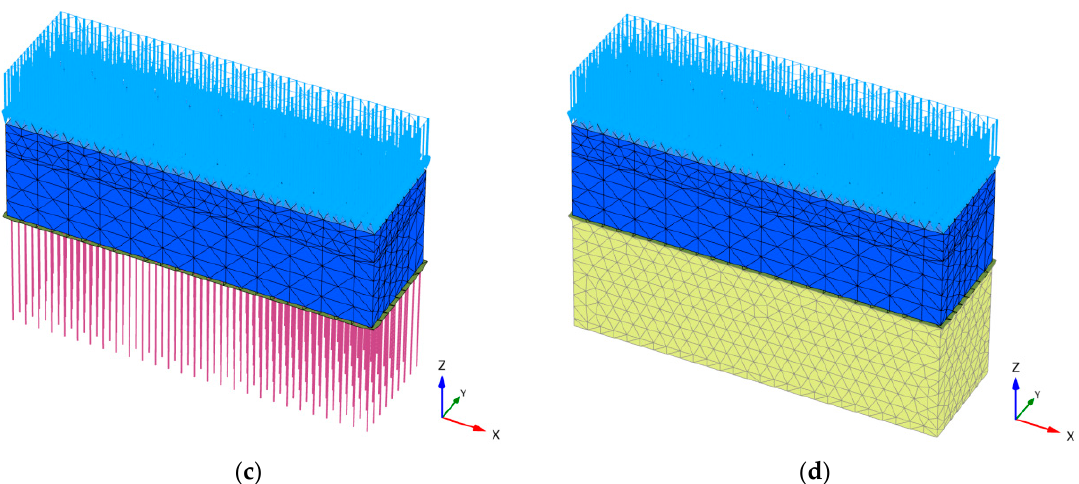
Figure 9. Pile–raft basement models for different simulation schemes: ( a ) Raft + concrete-bored piles (pile simulated by embedded pile element); ( b ) raft + cushion+ concrete-bored piles (pile simulated by embedded pile element); ( c ) raft + cushion + cement/fly ash/ gravel (CFG) piles (pile simulated by embedded pile element); ( d ) raft + equivalent reinforcement zone.